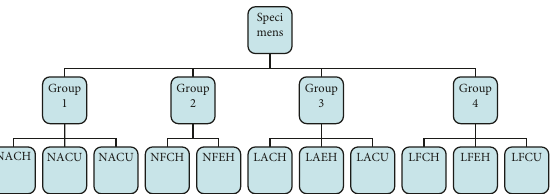
Figure 2: Main groups of specimens. N